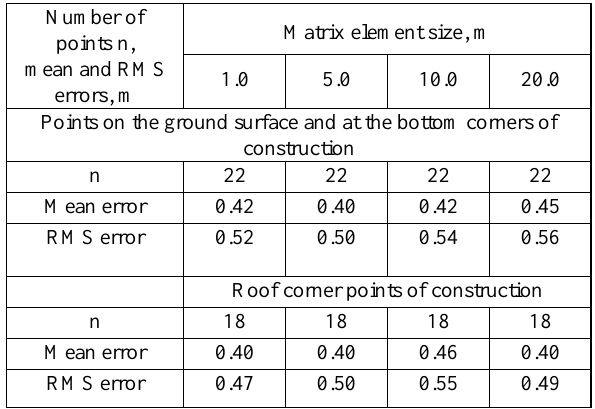
Table 4. The results of vertical positional accuracy estimation of